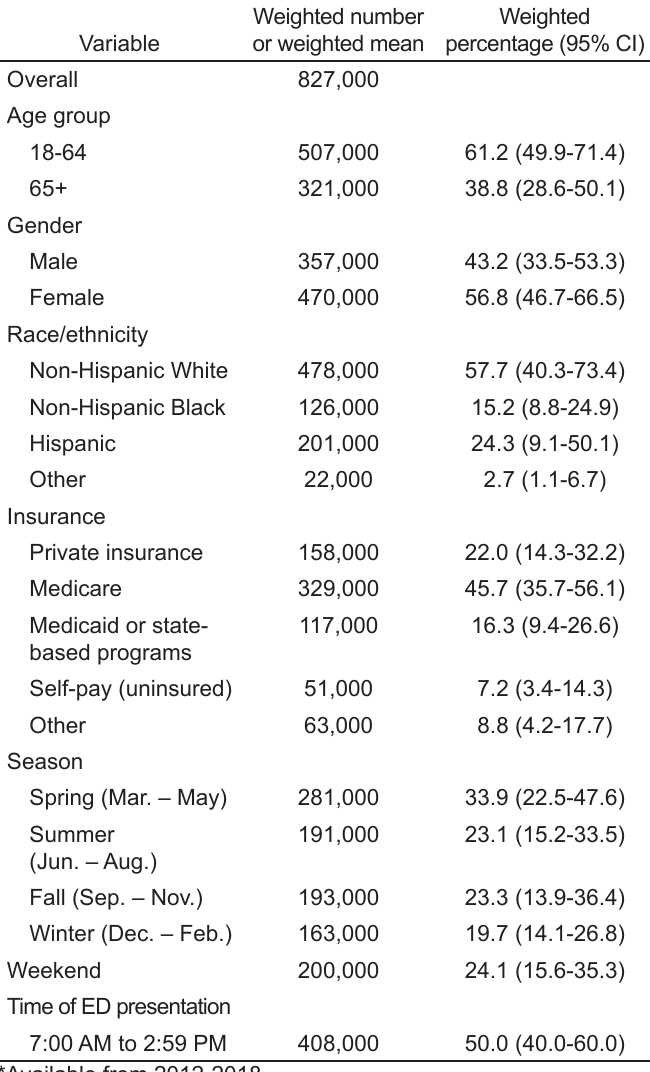
Table 2. Baseline clinical characteristics of emergency department high-risk revisit patients,